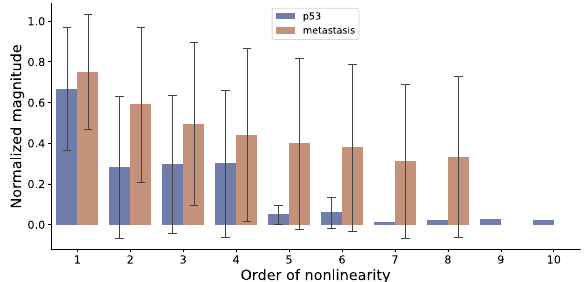
Fig. 4 A comparison of the spectrums of the magnitudes of nonlinearity of the models corresponding to the two extreme cases of approximability. The bars represent the mean absolute value of all the Taylor derivatives of the corresponding order, averaged over all the nodes of the corresponding model containing those terms. The maximum orders (in-degrees) of P53 and Metastasis are respectively 10 and 8. To compare the derivatives from different models they were normalized with respect to the maximum possible absolute value of a Taylor derivative of order ∣ α ∣ (Eq. (6)) of a Boolean function with output bias p , given by ð min ð p ; 0 : 5 Þ (cid:2) max ð p (cid:2) 0 : 5 ; 0 ÞÞ 2 j α j (proof provided in the “ Methods ” section). The error bars represent the standard deviation and not the con fi dence intervals of the means since they are not estimates. The errors appear large whenever the corresponding distribution of the magnitudes are bimodal with many values clustered close to